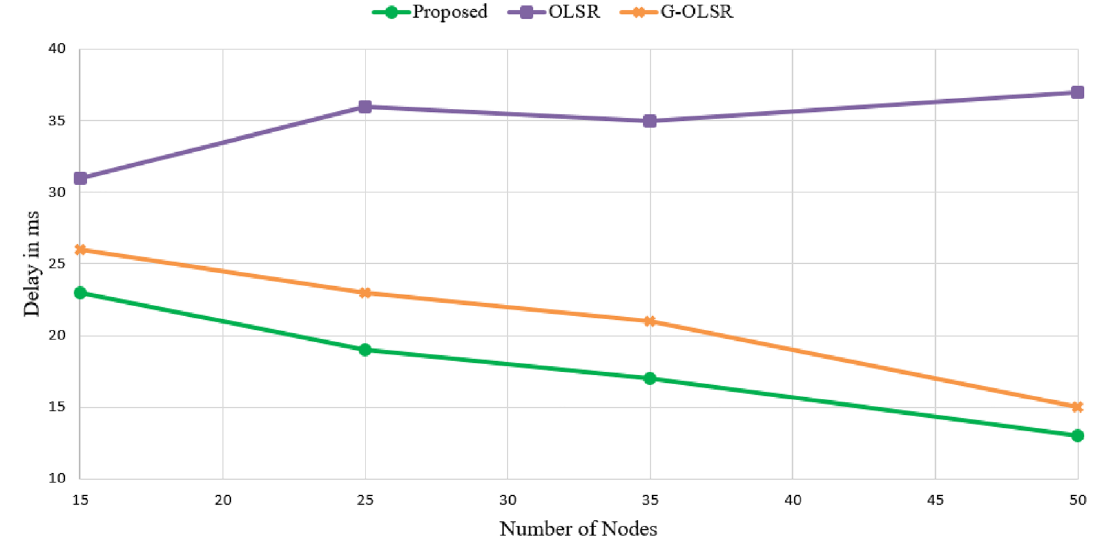
Figure 8. Comparison of different routing methods in terms of end-to-end delay.